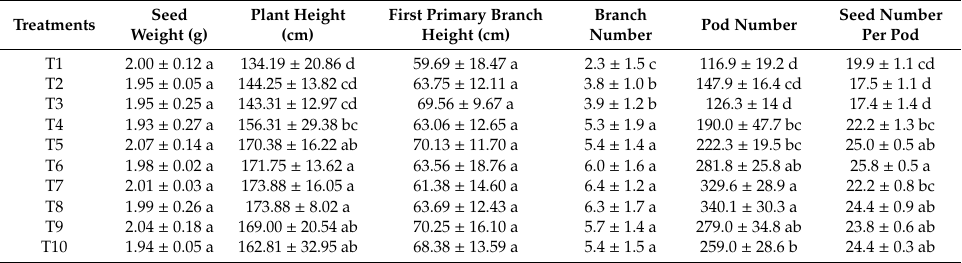
Table 3. Yield-related traits of Brassica napus under di ff erent treatments in the field trial. Treatments